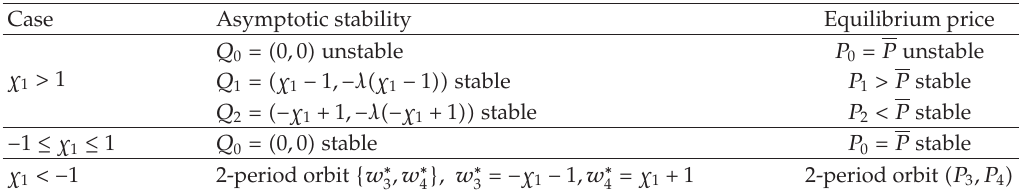
Figure 7: Fixed points in a rational market, for di ff erent values of parameter χ 2 : 30 in (cid:3) a (cid:6) , 15 in (cid:3) b (cid:6) , and 5 in (cid:3) c (cid:6) . T able 1: Fixed point solutions depending on parameter χ 1